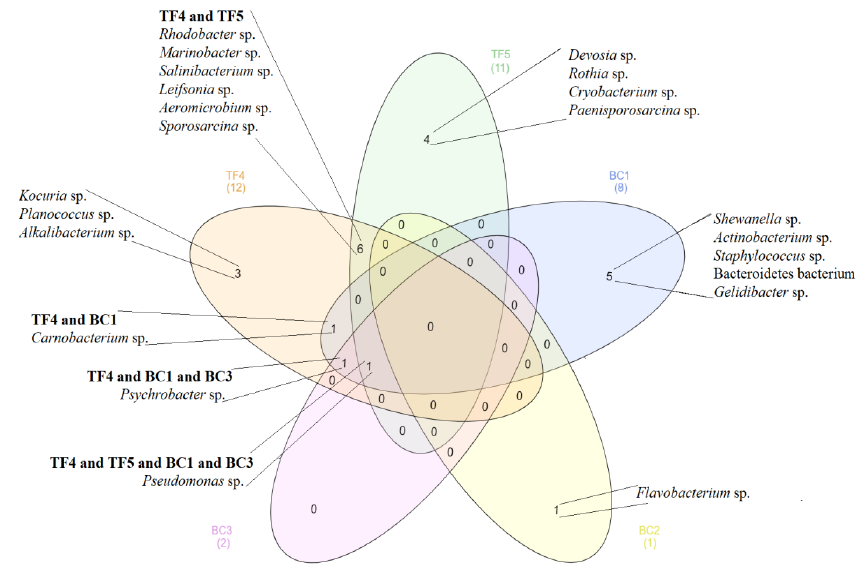
Figure 3. Venn Diagram constructed with data from the genera distribution of bacterial isolates among all brine samples.